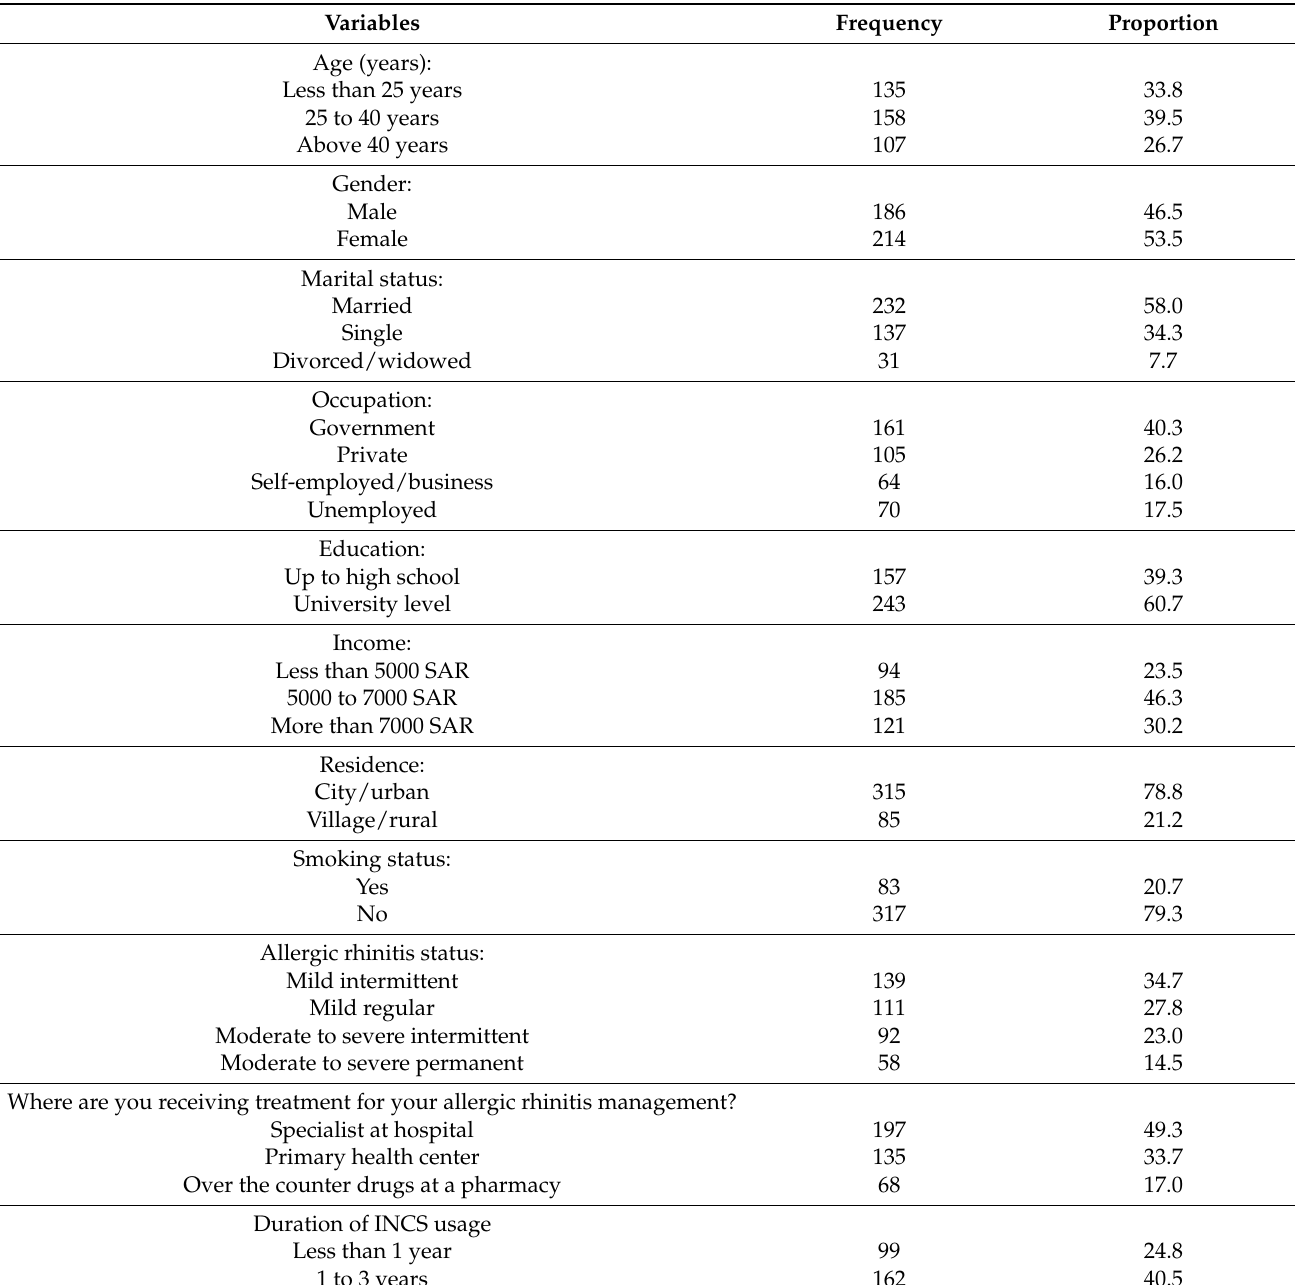
Table 1. Sociodemographic characteristics of the AR patients ( n =